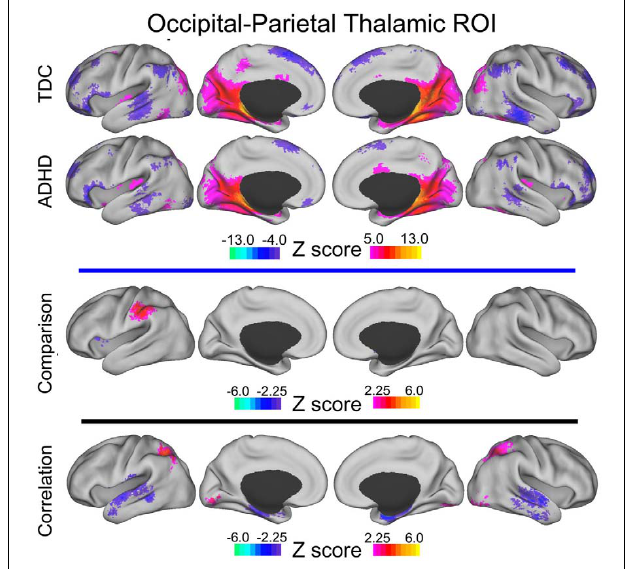
FIGUREA2 | Prefrontal thalamic voxelwise maps projected onto cortical surfaces. Each row displays the cortical surface for each voxelwise map generated from the prefrontal thalamic ROI: group maps forTDC, group maps for ADHD-C, maps from the comparative analysis (TDC vs. ADHD-C), and maps from the correlation analysis. Cortical surface projection was performed with the (PALS)-B12 atlas (Van Essen, 2005) and the software Caret (Van Essen et al., 2001).